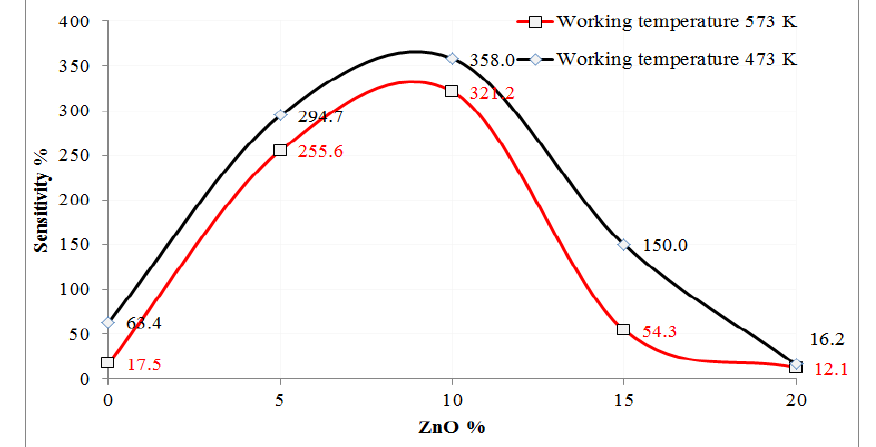
Fig.11: Variation of sensitivity with ZnO atomic ratio for (SnO